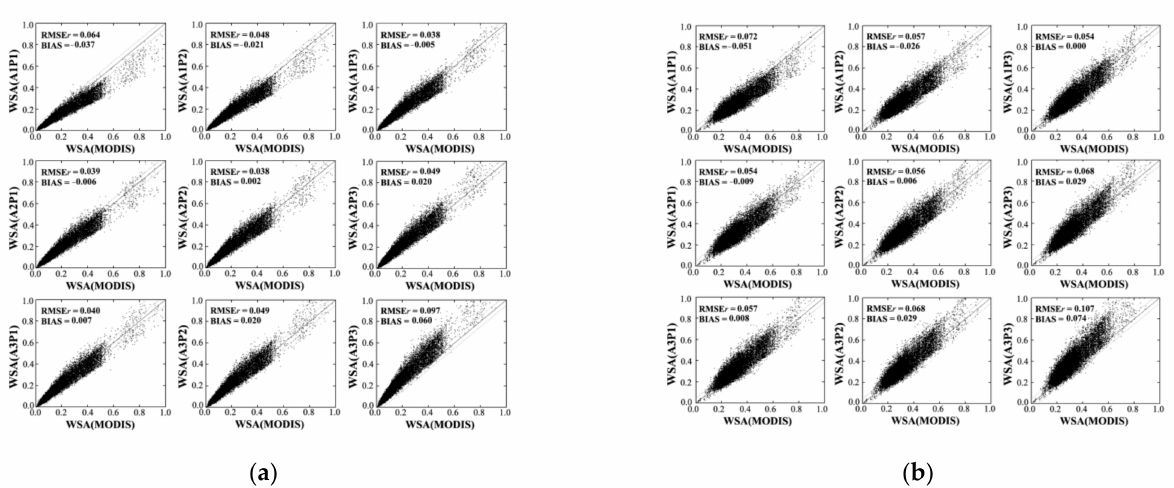
Figure 10. Comparison of MODIS albedo with albedo retrieval from different BRDF archetypes and nadir reflectance with a random noise range from − 20% to 20% in the red ( a ) and NIR ( b ) bands. For the albedo retrieval form nadir reflectance with noise, the A1-series archetypes would underestimate the albedo, while A3-series archetypes would overestimate